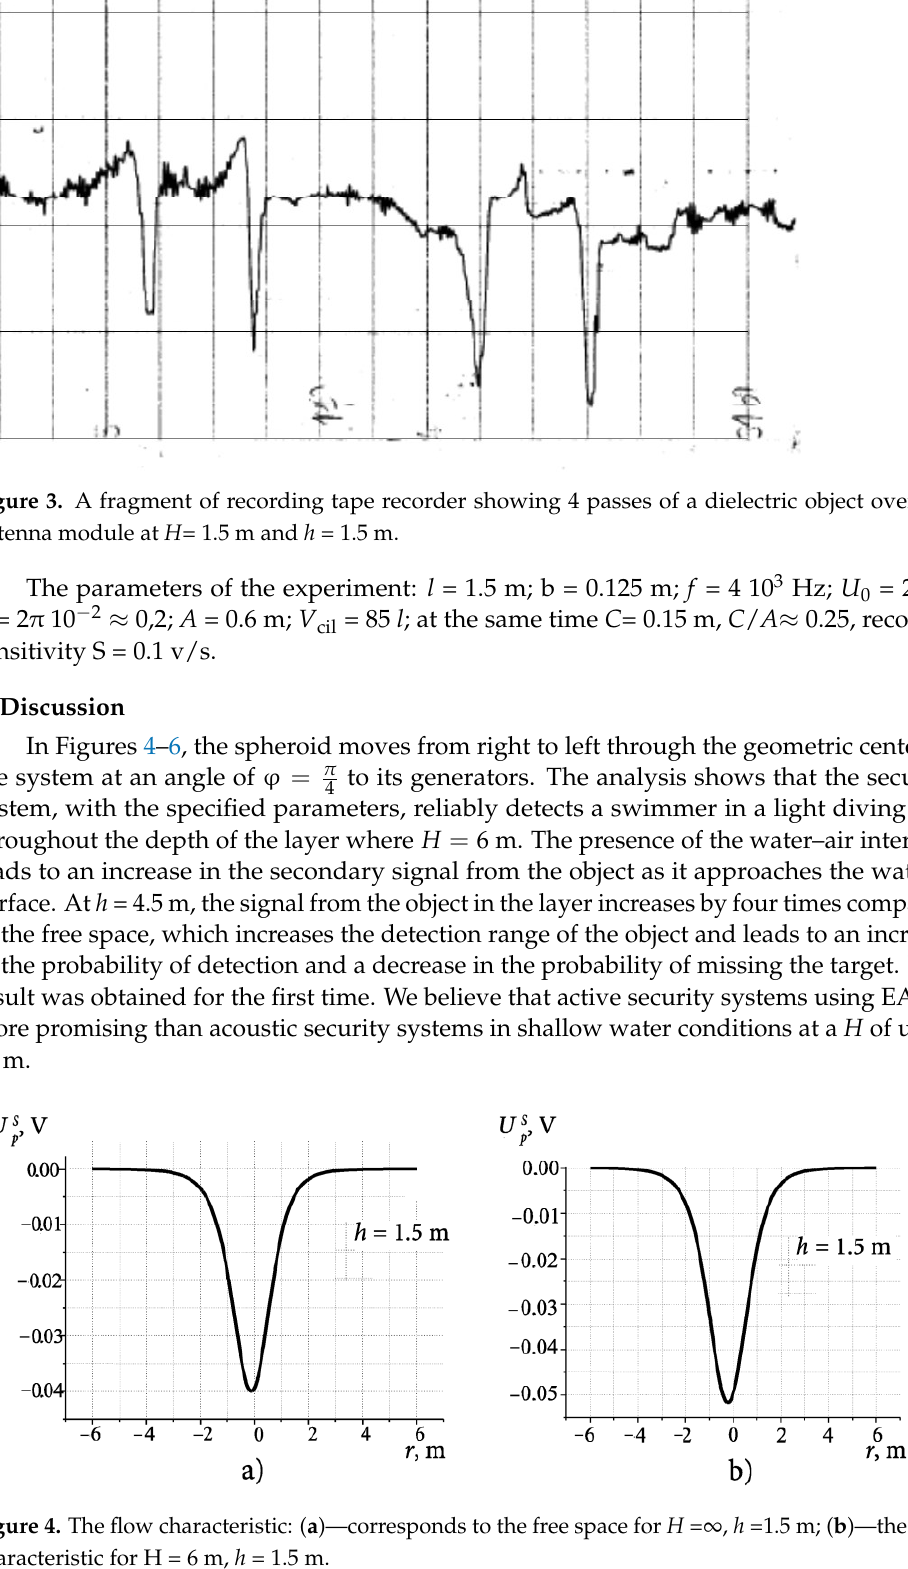
Figure 5. The flow characteristic:( a ) — corresponds to the free space for H =∞, h =3 m; ( b ) — the flow characteristic for H =6 m, h = 3 m. Figure 6. The flow characteristic: ( a ) — corresponds to the free spacefor H =∞, h =1.5 m; ( b ) — the flow characteristic H =6 m, for h = 4.5 m.